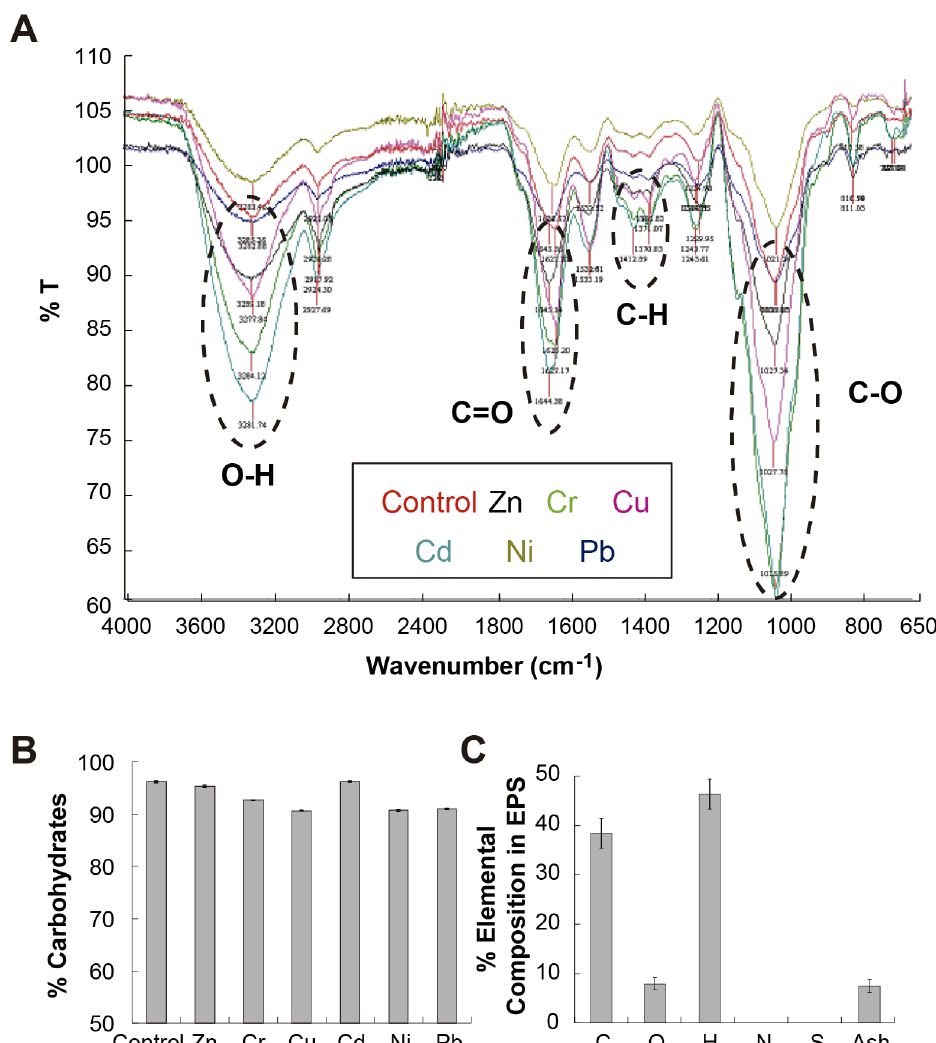
Fig 4. Chemical Characterization of EPS. The data show chemical analysis of the EPS produced when Rhodotorula mucilaginosa strain UANL-001L is grown in both the absence and the presence of the different transition and post-transition metals (Cd(II), Pb(II), Zn(II), Ni(II), Cu(II) and Cr(VI)). A) FTIR of the samples with the different peaks highlighted and tagged with the chemical group corresponding to each specific wavenumber. B) Percentage of carbohydrates present in the EPS. C) Average composition of carbon, oxygen, hydrogen, nitrogen, sulfur and ashes of all the exopolysaccharides produced after growth with exposure to each of the metals and the